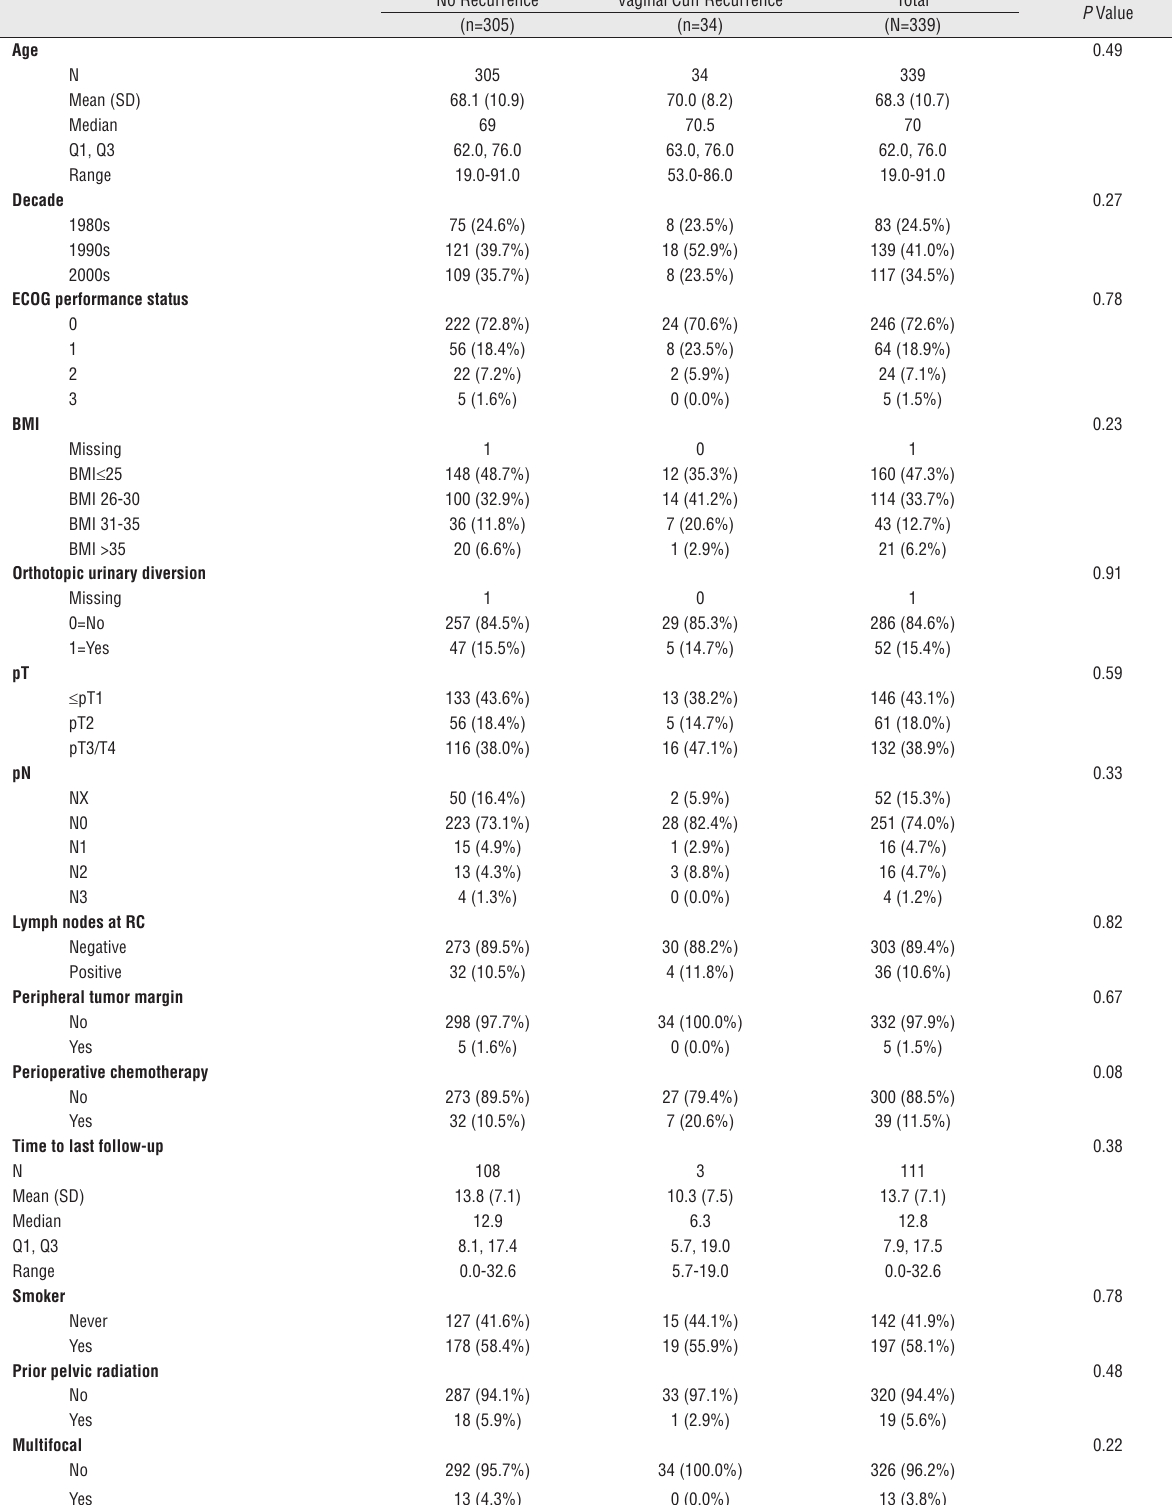
Table 2 - Distribution of Risk factors Among vaginal cuff Recurrence vs No